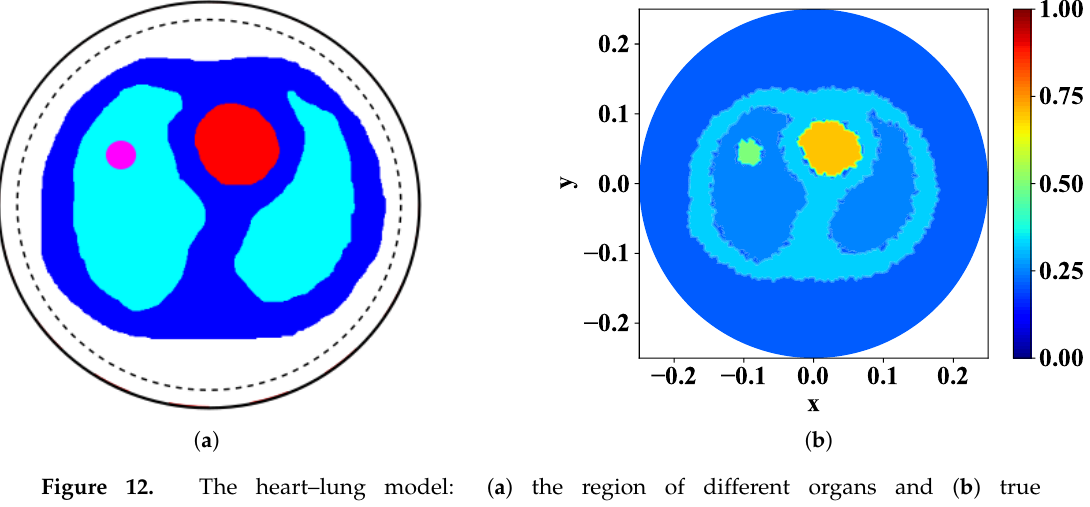
Figure 12. The heart–lung model: ( a ) the region of different organs and ( b ) true conductivity